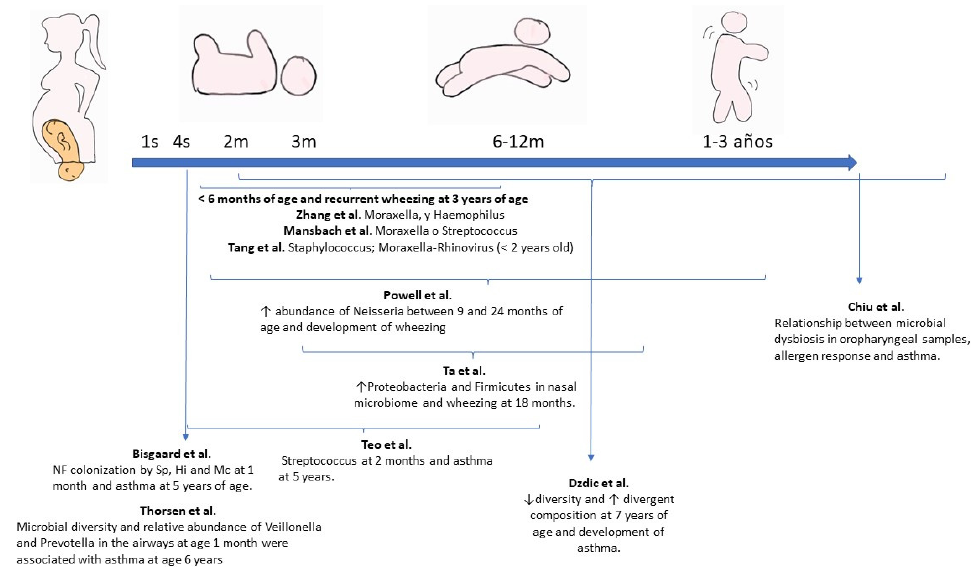
Figure 3. Main studies on respiratory microbiome and risk of asthma in children. Modified and with permission from Valverde-Molina J. [22]. NF: Nasopharyngeal; Sp: Streptococcus pneumoniae; Hi: Haemophilus influenzae; Mc: Moraxella catarrhalis. Bisgaard et al. [74]; Chiu et al. [76]; Dzdic et al. [81]; Mansbach et al. [85]; Powell et al. [83]; Ta et al. [77]; Tang et al. [87].; Teo et al [75,79]; Thorsen et al. [82]; Zhang et al. [84].